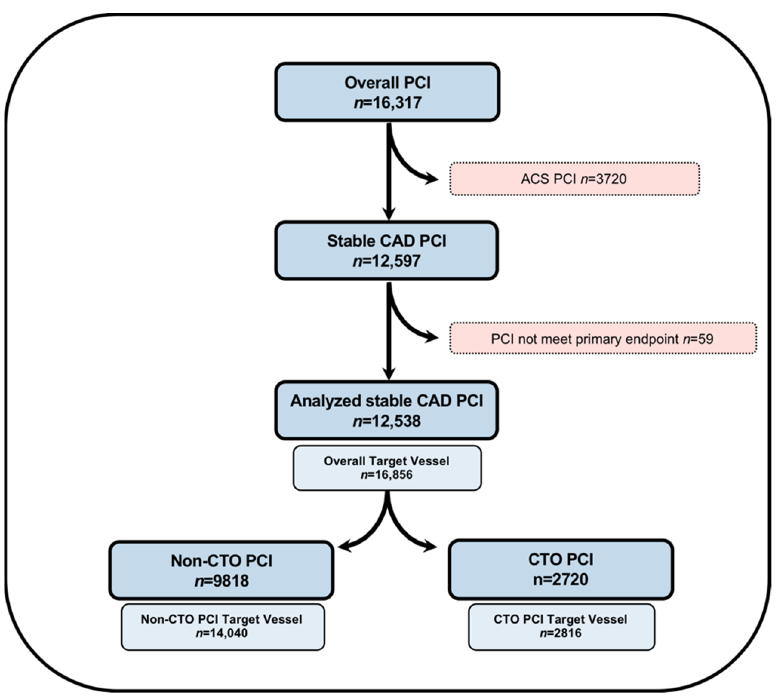
Figure 1. Flowchart of patient cohort selection in the current study. ACS, acute coronary syndrome; CAD, coronary artery disease; CTO, chronic total occlusion; and PCI, percutaneous coronary intervention.